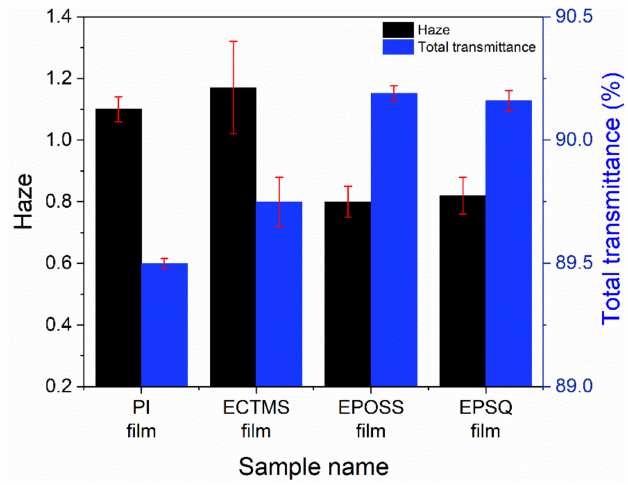
Figure 4. Summary of optical properties of bare PI film and coated films (haze and total transmit- tance).